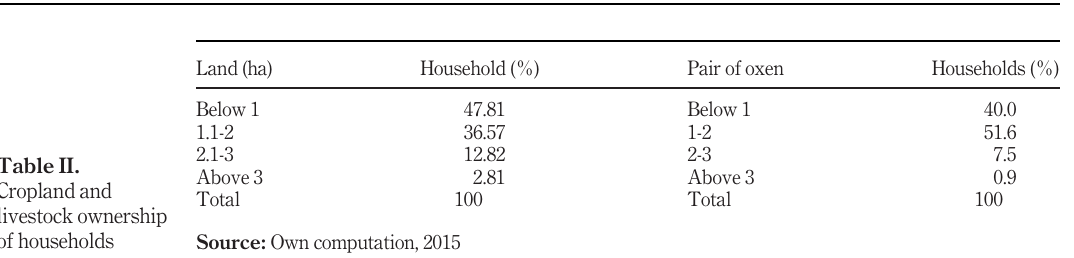
Table I. Family size and dependency ratio of sample households